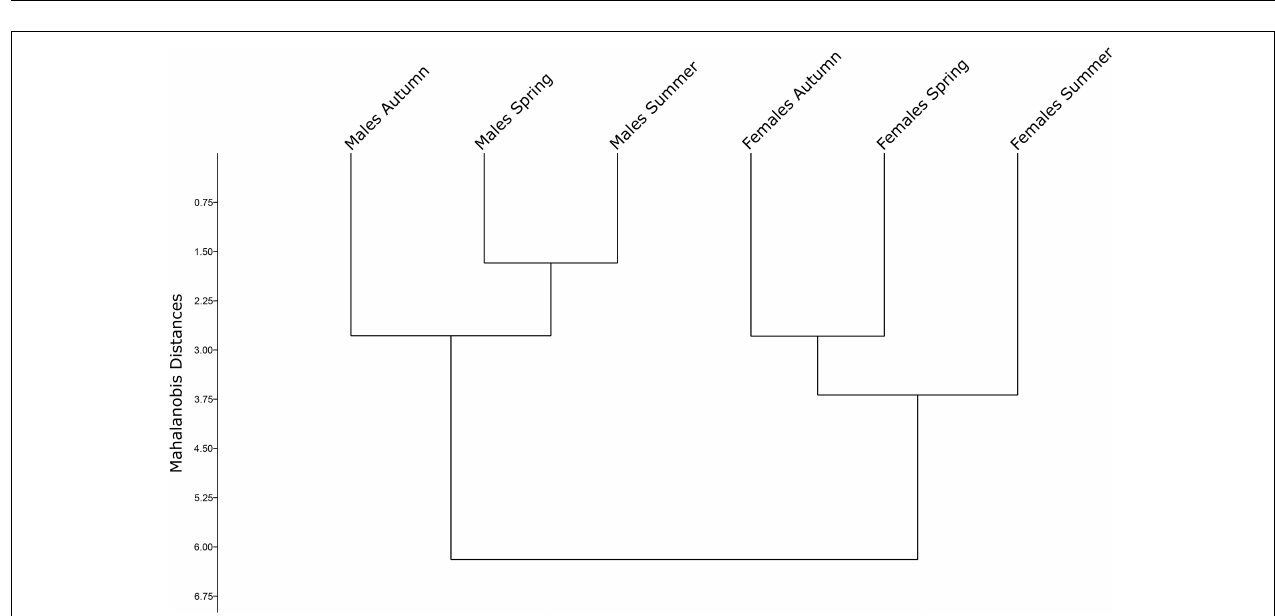
FIGURE 5 | Mahalanobis distances of seasonal mosquito groups (Spring, Summer, and Autumn) represented in an unweighted pair group method with arithmetic mean.